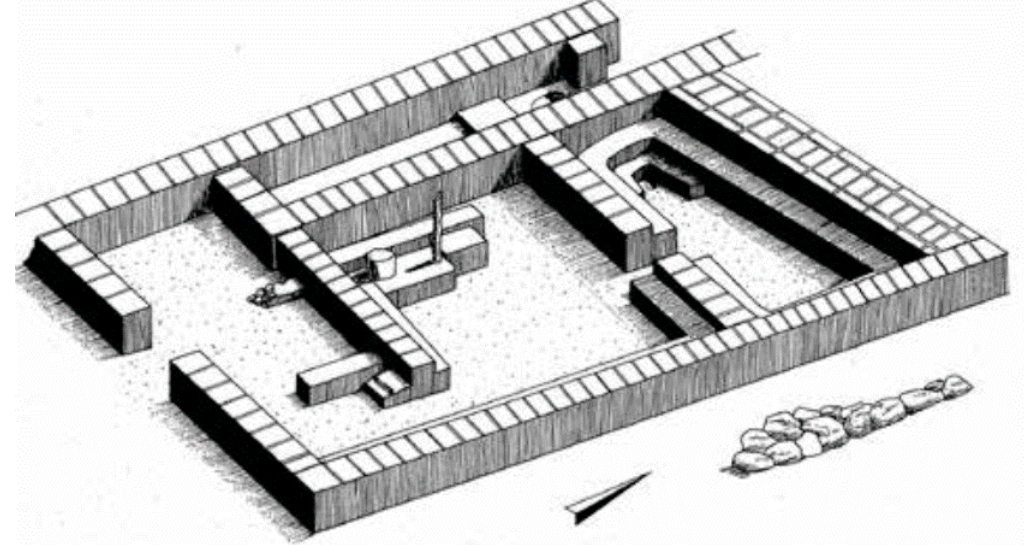
Figure 5. Isometric view of the Level R2 temple at Beth-Shean (From Mullins and Mazar 2007: Figure 3.19; courtesy of Amihai Mazar and the Israel Exploration Society).